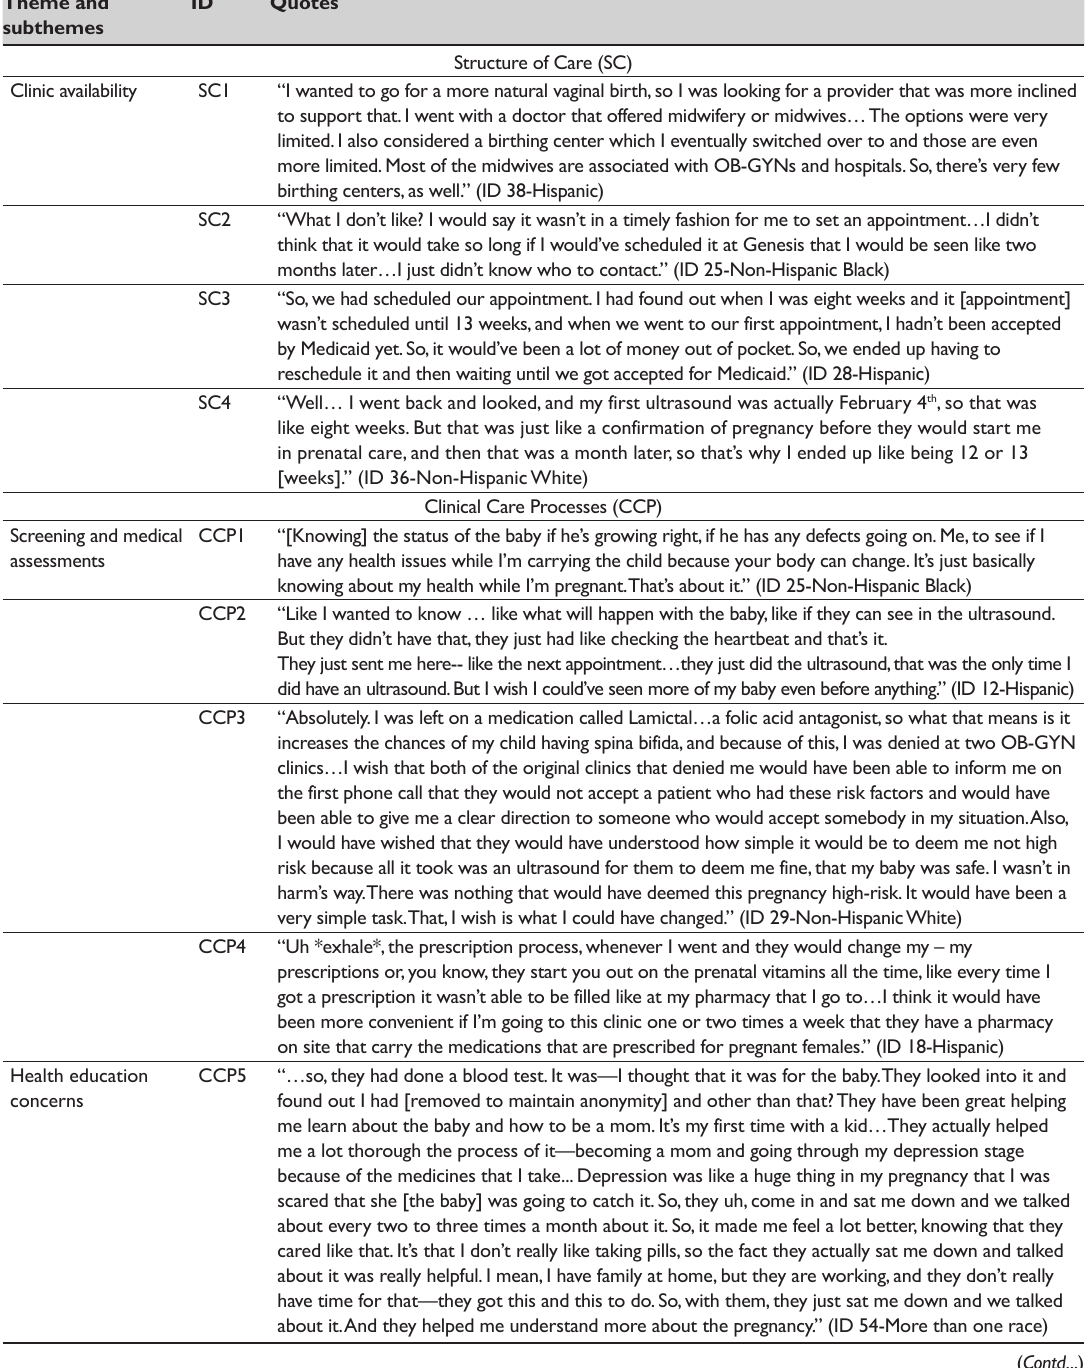
Table 2: Quality of prenatal care themes and subthemes in study with representative quotes Theme and ID Quotes subthemes Structure of Care (SC) Clinic